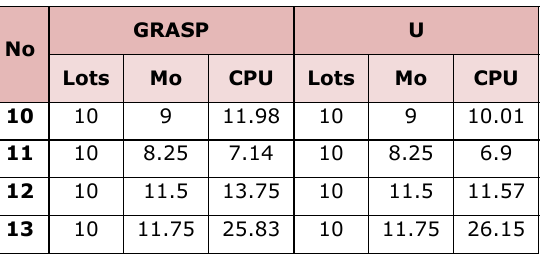
Table 10. “Comparison between the results obtained by both heuristic procedures”. Source: